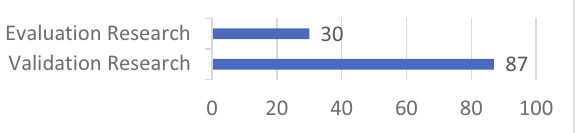
Figure 5. Research type